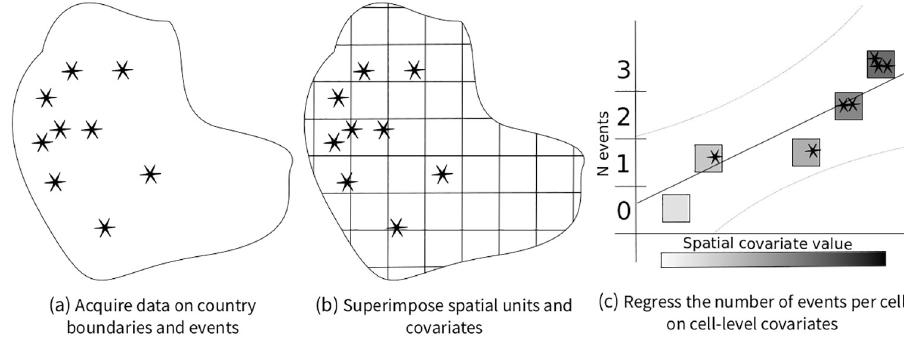
Fig 1. Illustration of the workflow in spatial event aggregation